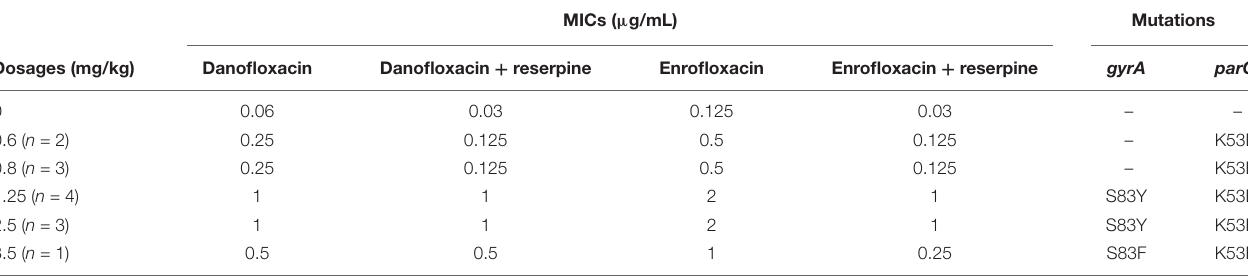
TABLE 4 | Quinolone susceptibility and identification of resistant mutants associated with different dosages of